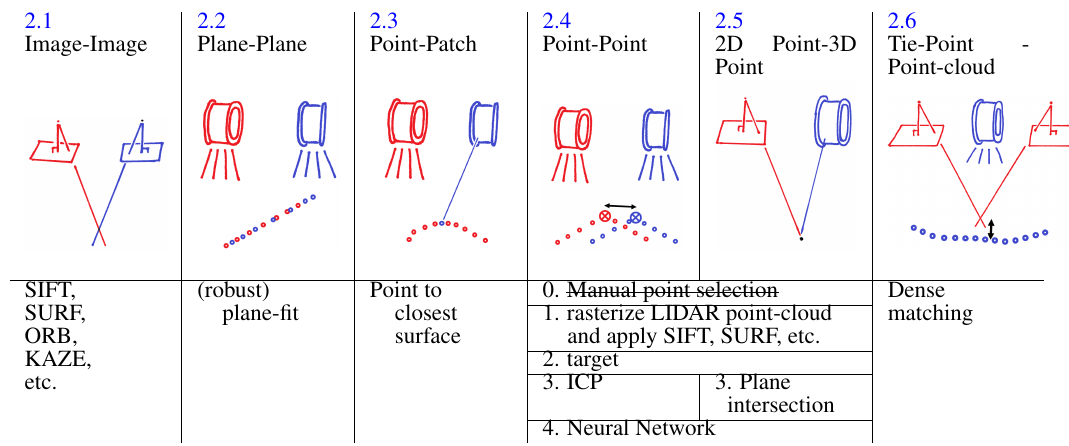
Table 2. Differents type of links for Photogrammetry, Laser-Scanning and Photo-LIDAR